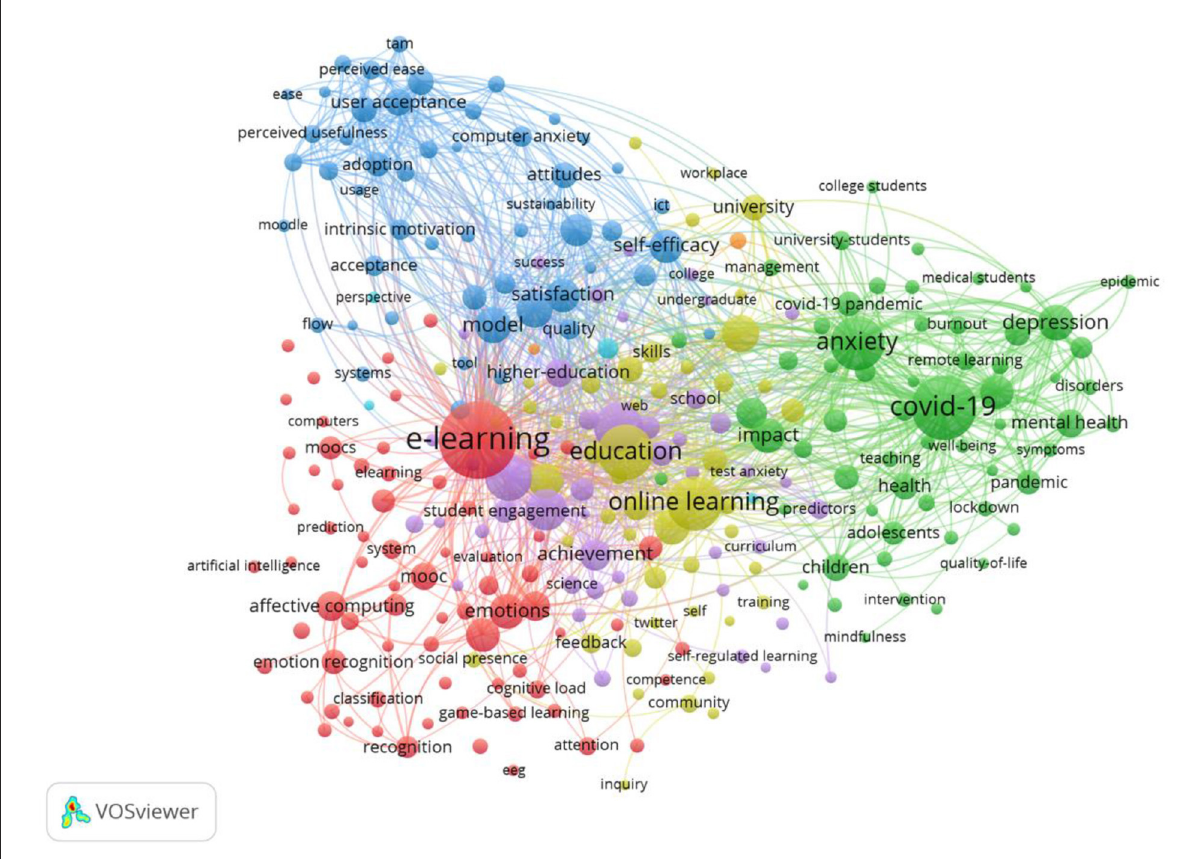
FIGURE1 The bibliographic